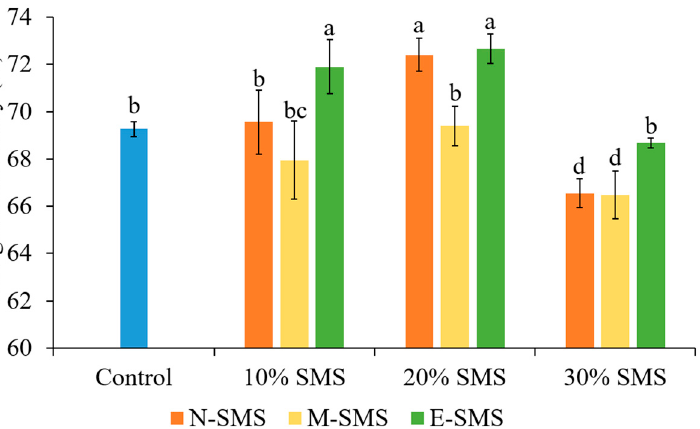
Figure 2. Biological efficiency of P. ostreatus fruiting bodies in different substrates (mean ± SD, n = 3). Different letters above the bars indicate significant differences at p < 0.05.